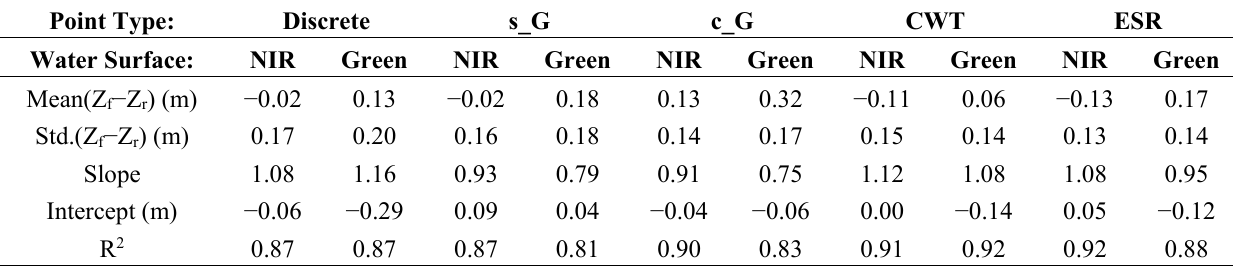
Table 2. Comparison of LiDAR retrieved water depths to field measured ADCP water depths for the Snake River. Results in